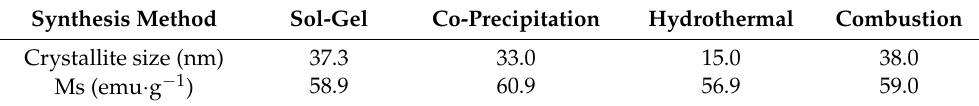
Table 1. Effect of synthesis method in structural and magnetic properties of catalyst cobalt ferrite [65–67]. Synthesis Method